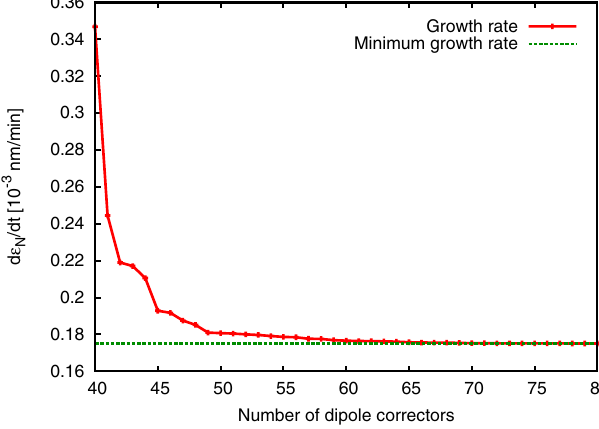
FIG. 6. (Color) Minimum achievable emittance growth rate for different numbers of BPM patterns. No more than the 25–30 most important patterns have to be considered to achieve almost the same (optimal) performance as when all BPM information is taken into account. The figure also shows how well the trajectory can be controlled with information from a limited number of BPM